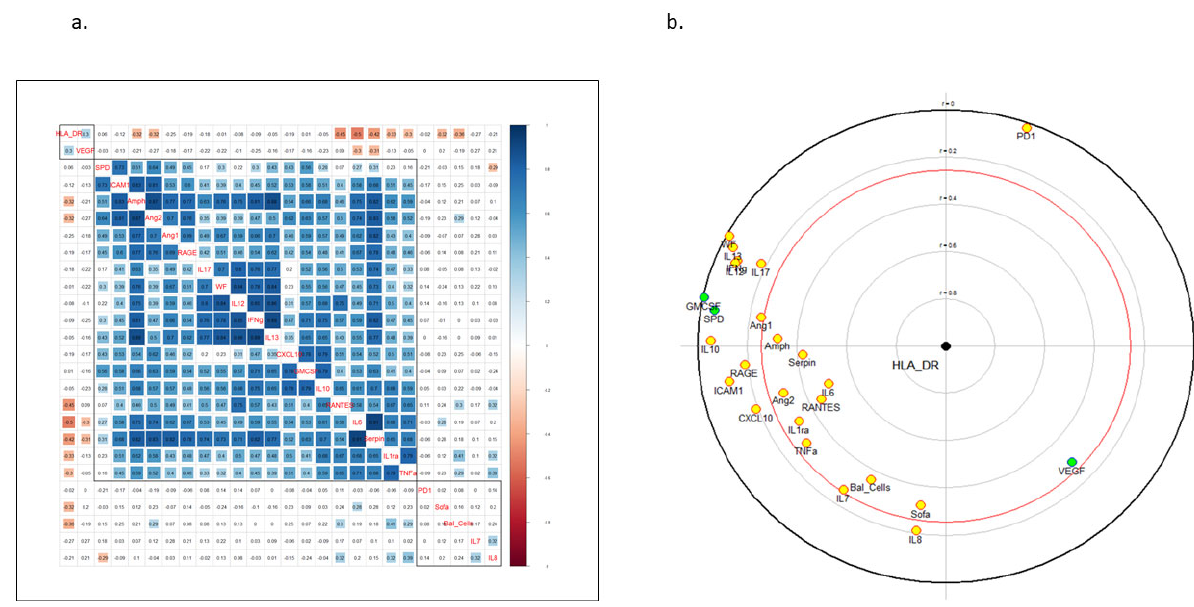
Figure 3. ( a ) Correlation matrix of broncho-alveolar lavage fluid monocytic HLA-DR expression (in MFI), concentrations of cytokines/alveolar epithelial/endothelial injury biomarkers, SOFA score and total BAL cellularity (per mL) in pneumonia- related ARDS patients ( n = 70). Spearman correlation coefficients are provided for continuous-continuous variables correlations, with positive (blue) and negative (red) correlation coefficients indicating statistical significance at the p < 0.05 level after Benjamini-Hochberg correction for test multiplicity. ( b ) Focused principal component analysis (FPCA) displaying the relationships between HLA-DR expression on alveolar monocytes and cytokines/alveolar epithelial/endothelial injury biomarkers concentrations in BAL fluid of pneumonia-related ARDS patients. FPCA is a simple graphical display of correlation structures focusing on a particular dependent variable. The display reflects primarily the correlations between the dependent variable and all other variables (covariates) and secondarily the correlations among the covariates. The dependent variable (HLA-DR expression on alveolar monocytes, expressed in mean fluorescence intensity) is at the center of the diagram, and the distance of this point to a covariate faithfully represents their pairwise Spearman correlation coefficient (using ranked values of continuous variables). Green covariates are positively correlated, and yellow ones are negatively correlated. The red circle delimits statistical significance (at the 5% level). The diagram also shows relationships among covariates. Their relative position is informative as follows: two covariates close to one another indicate a strong positive correlation between them; two diametrically opposed covariates indicate a strong negative correlation between them; two covariates making a right angle with the origin indicate absence of correlation between